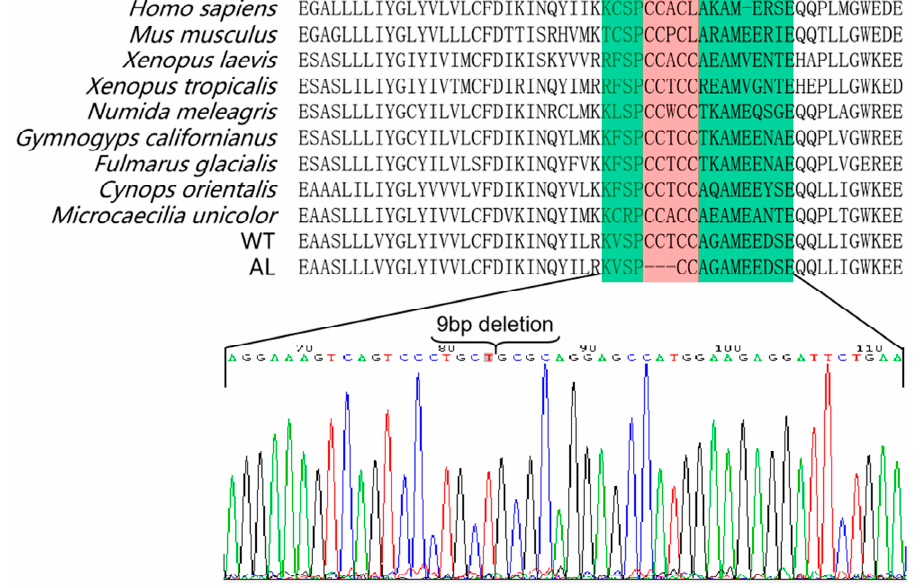
Figure 7. Protein sequence alignment of SLC24A5 between WT, AL Andrias davidianus, and other vertebrates. The red box marks the 3-amino-acids mutation of AL Andrias davidianus .